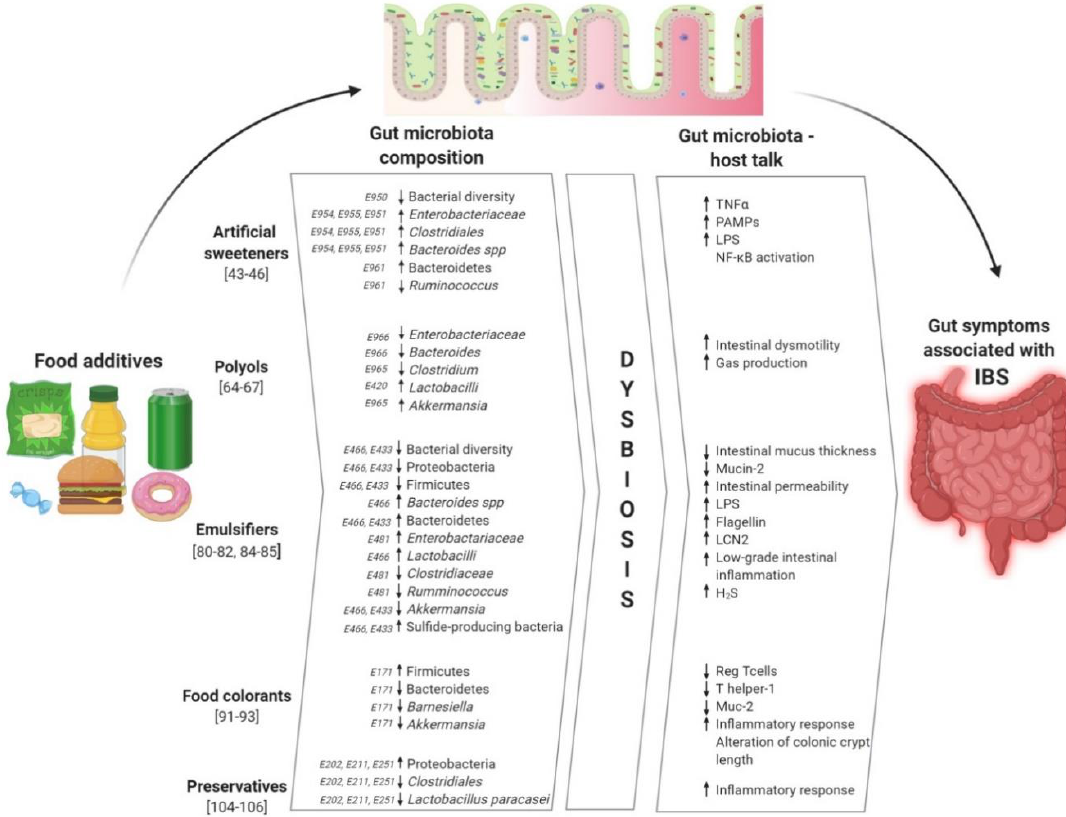
Figure 1. Food additives, gut microbiota, and irritable bowel syndrome (non-exhaustive list of food additives). Abbreviations: E171, titanium dioxide; E202, potassium sorbate; E211, sodium benzoate; E251, sodium nitrate; E420, sorbitol; E433, polysorbate 80; E466, carboxymethyl cellulose; E481, sodium stearoyl-2-lactylate; E950, acesulfame potassium; E951, aspartame; E954, saccharin; E955, sucralose; E961, neotame; E965, maltitol; E966, lactitol; LCN2, lipocalin-2; IBS, irritable bowel syndrome; LPS, lipopolysaccharides; Mucin-2, oligomeric mucus gel-forming protein encoded by the MUC2 gene; NFκB, nuclear factor-kappa B; PAMPs, pathogen associated molecular patterns; Reg T cells, regulatory T cells; TNF, tumor necrosis factor.